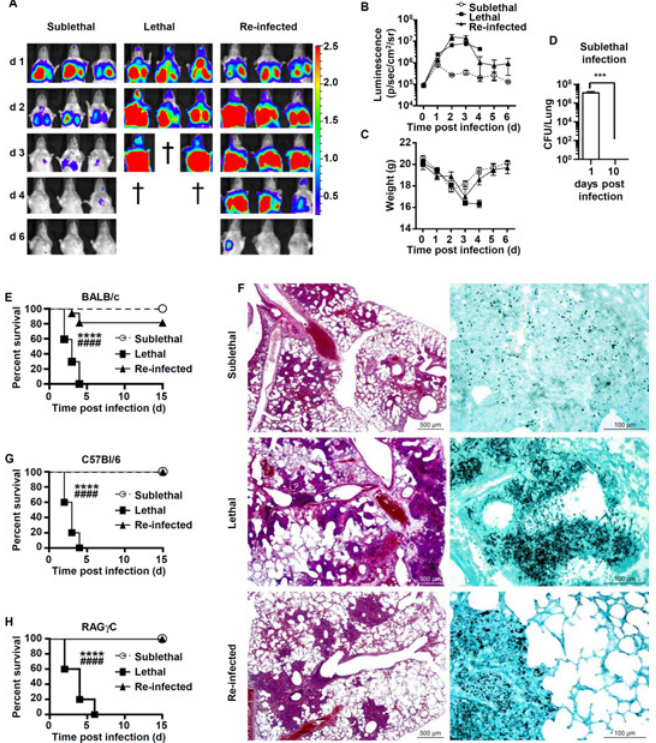
Fig 1. Mice recovering from sublethal A . fumigatus conidia inoculum are protected in a T-, B- lymphocytes or NK independent manner. Mice were either infected at day 0 with a sublethal (SL) or a lethal (L) concentration of A . fumigatus conidia. Re-infected (Re-Inf) mice were first infected with a SL dose and 10 days later were challenged with the L dose. The mice survival was followed on a daily basis during 15 days p.i. (A) A . fumigatus- emitted bioluminescence images from the thorax of representative BALB/c mice taken using the IVIS spectrum (Perkin) (B) Quantification (photons per second) of bioluminescence signal from mice chest areas using Living Image software (Perkin). (C) Modulation of the body weight in the three infection settings. (D) Colony forming unit from lungs homogenates. Mice were sacrificed from the “ SL ” group at day 1 and 10 and lung homogenates were collected and plated to determine the colony forming units (CFU). (E) Survival rate of BALB/c mice in the three infection settings. (F) Representative lung sections from mice at 48 h p.i. Left panels show Hemalun and right panel methenamine silver stained lung sections. Hemalun staining visualizes the inflammatory foci (purple), whereas silver staining visualizes fungal elements (black). (G) Survival rate of C57BL/6 mice in in the three conditions (H) Survival rate RAG -/- γ c -/- mice in the three conditions. ( **** p = 0.0001 L dose vs SL dose; ####p < 0.0001 L dose vs Re-Inf mice; n = 10 to 15 mice per